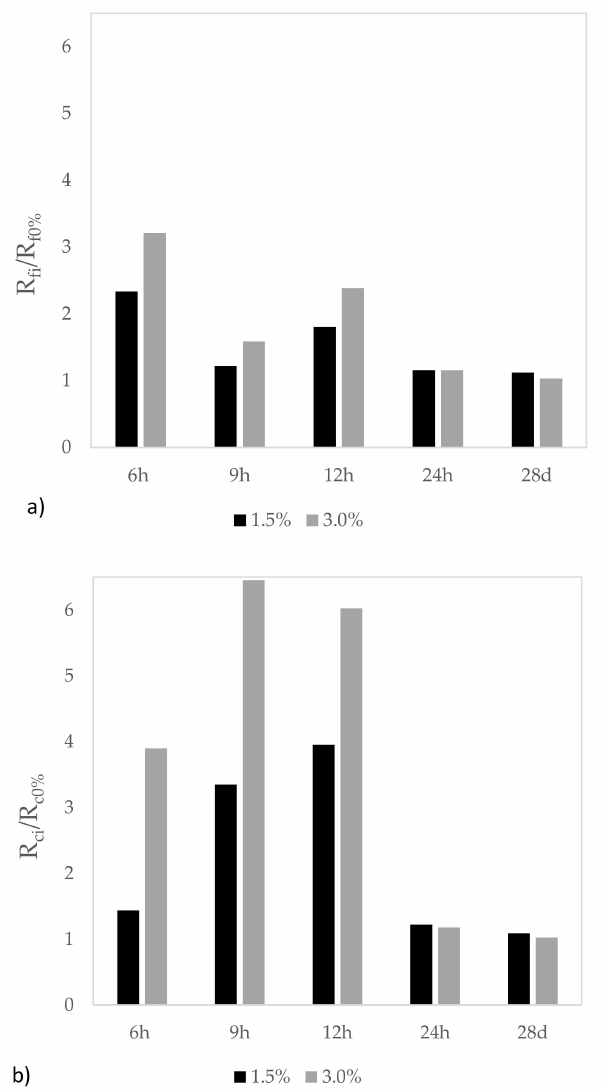
Figure 6. Ratio between mortar with and without setting accelerator: ( a ) flexural strength, ( b ) com- pressive